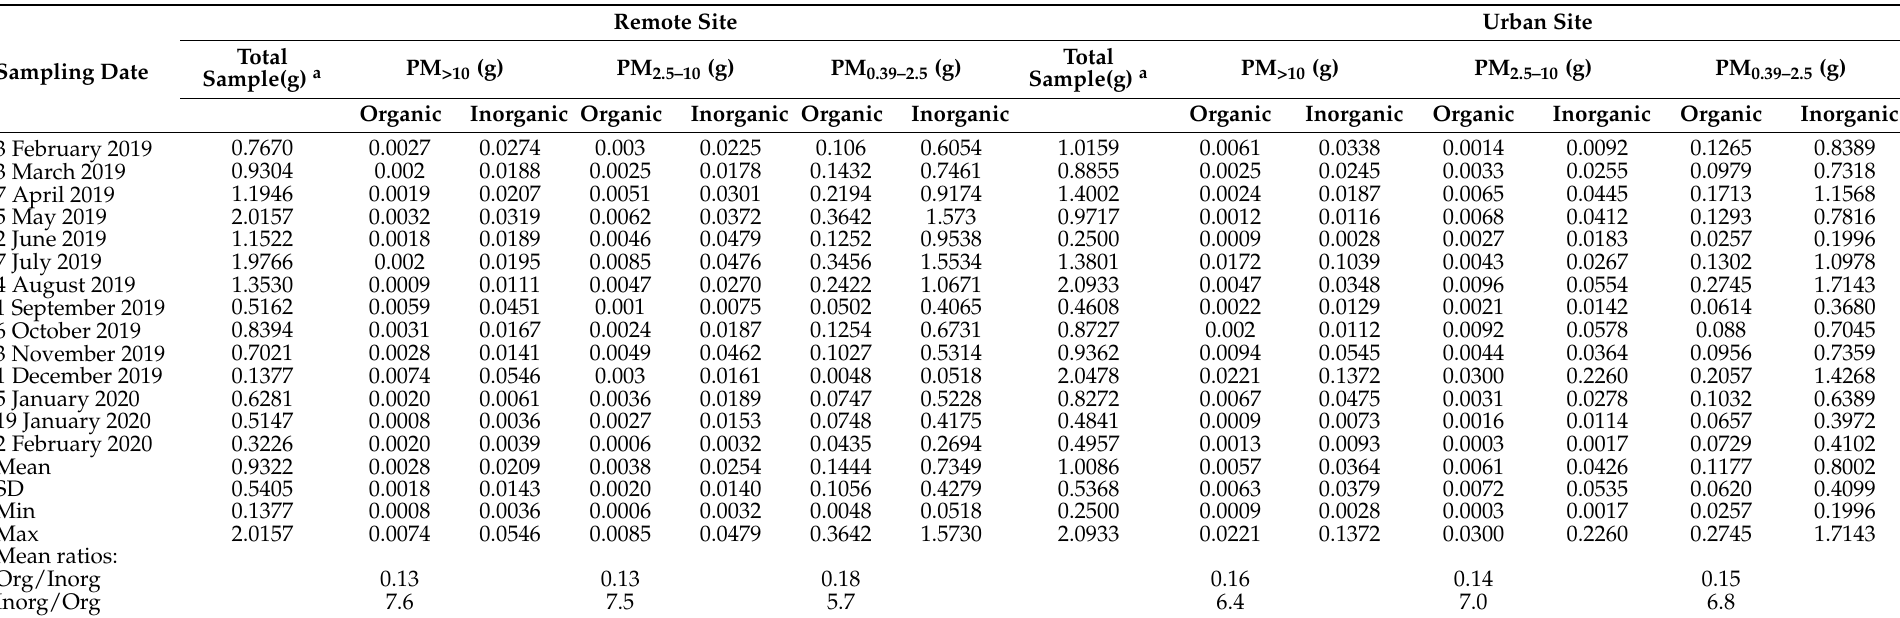
Table 1. Aerosol samples: weight (in grams) of total aerosol sample and of organic and inorganic components in each particulate size